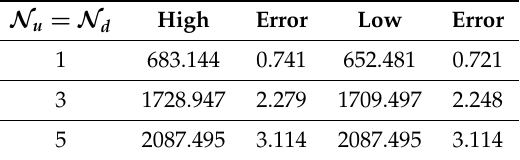
Table 5. Swing option values as a function of the number of exercise rights with a five-dimensional underlying asset. Parameter values used are base volume = 60 units, S 0 = 40, b = 20, R = 4000, m = 5, and no usage